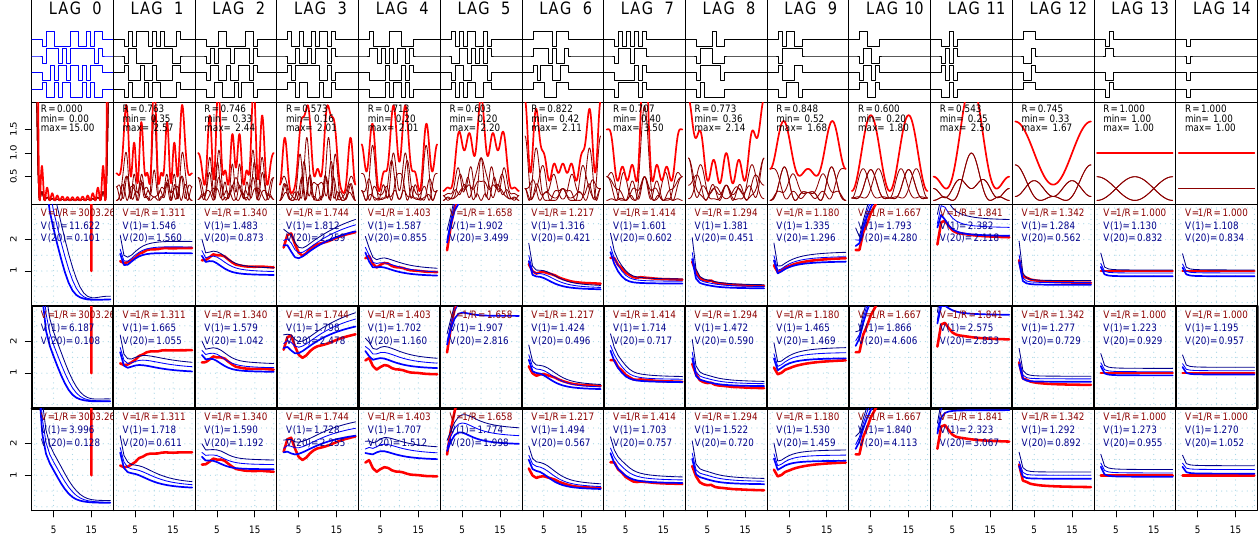
Fig. 3. Evaluation of a randomly chosen 4-code binary sequence of length 15. In the first row of panels the ambiguity functions for each lag are shown, corresponding to all full lag values. For lag 0 we show the codes themselves (drawn in blue), as the ambiguity functions would be just constants shapes of length equal to the length of the total pulse. The second row of panels shows the average of the squared moduli of the Fourier transforms of the ambiguity over the code set (red) and also the individual terms in this average shown by the darker red lines in bottom. The lower three panels show the behavior of variances of lag profiles if integrated to different resolutions between 1 and 20 baud lengths. The fourth row corresponds to using fractional lags of ± 2, ± 1 and 0 to represent each full lag, while in the third row we have used fractional lags ± 1 and 0 and in the fifth row fractional lags ± 3, ± 2, ± 1 and 0. The red curves in all the rows correspond to a simple calculation using no fractional lags at all, while the blue curves correspond to more realistic analysis, all using the fractional lags specified but 3 different kernels for range integration. The simple red curves are used for fast computer searches and we see that they rather well approximate the more realistic variance